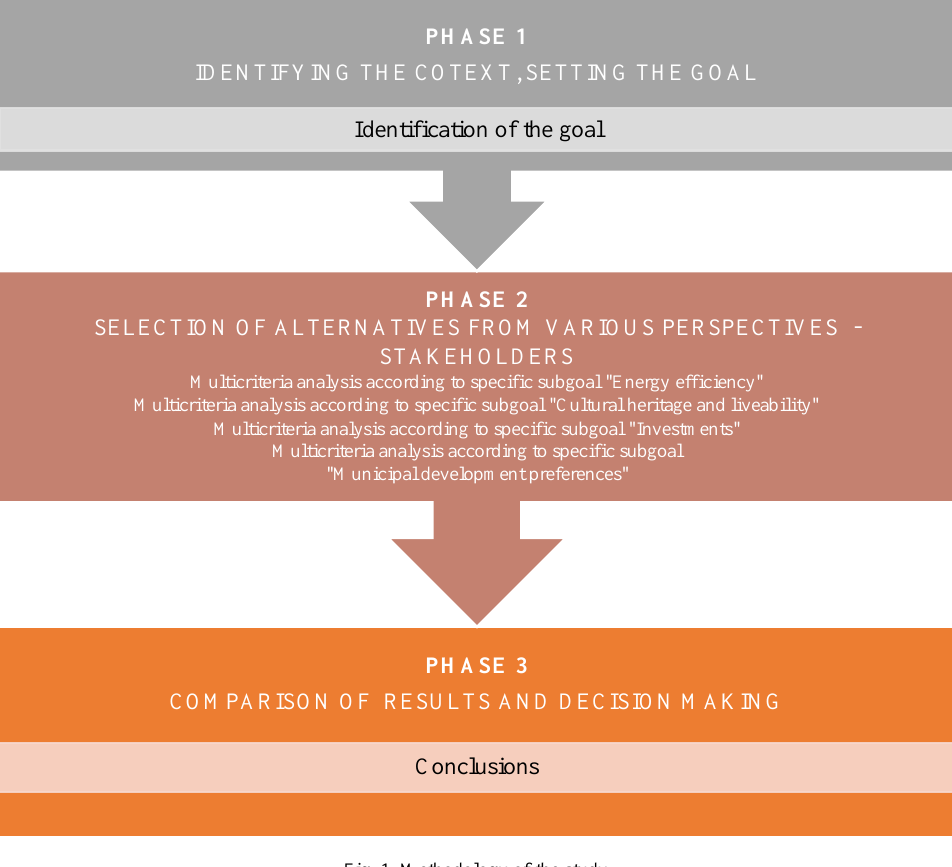
Fig. 1. Methodology of the